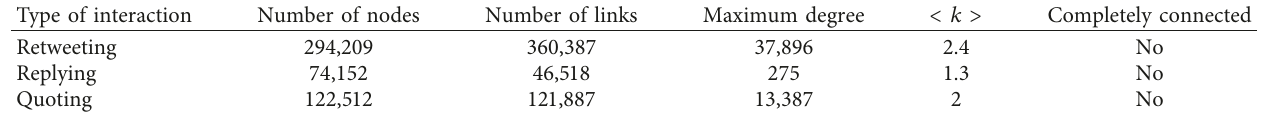
Table 1: Main structural properties of the interaction